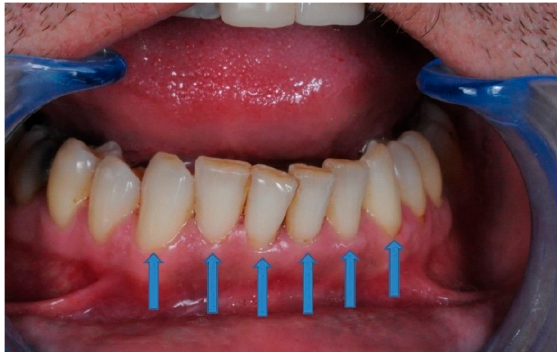
Figure 6. Example of symmetric frontal teeth allocation in the study (43, 42, 41, 31, 32, and 33 in this image).